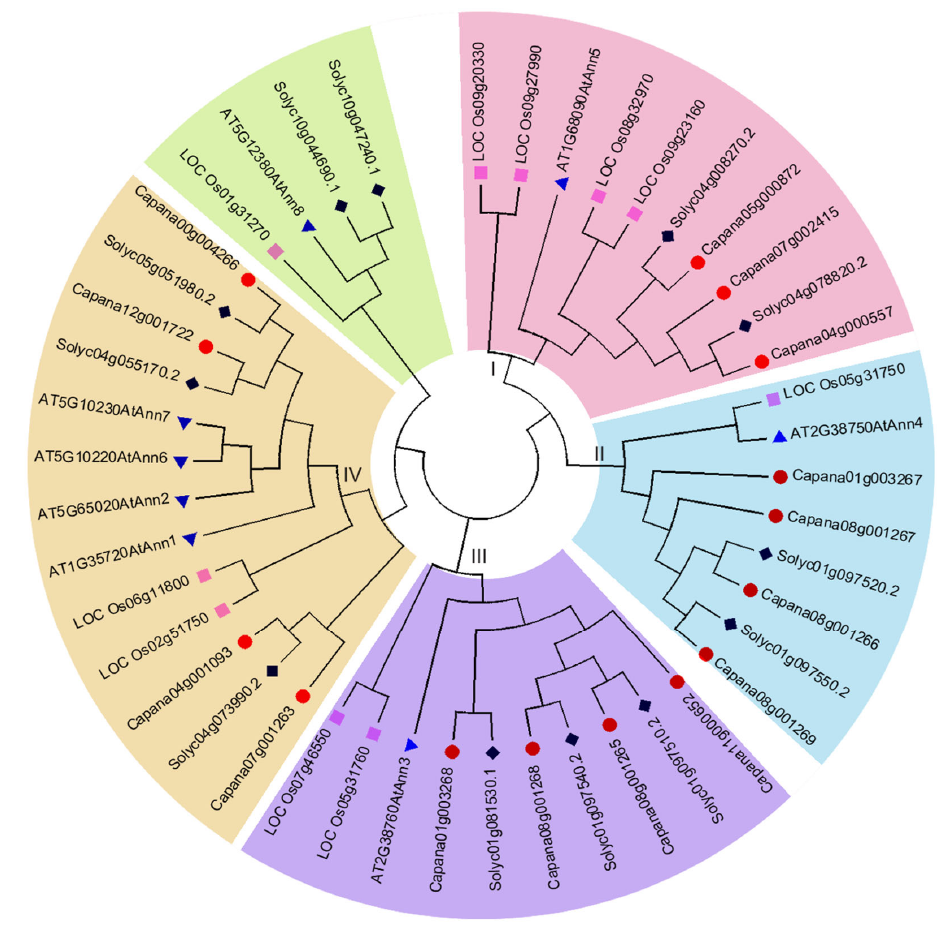
Figure 2. Phylogenetic analysis of pepper CaAnn protein sequences. The 45 amino acid sequences of four plant species were compared with Clustal-W, and the phylogenetic tree was constructed in MEGA-6 using the neighbor-joining method. The roman letters represent the four groups. The different branch colors represent pepper (red), tomato (black), rice (pink), and Arabidopsis (blue).